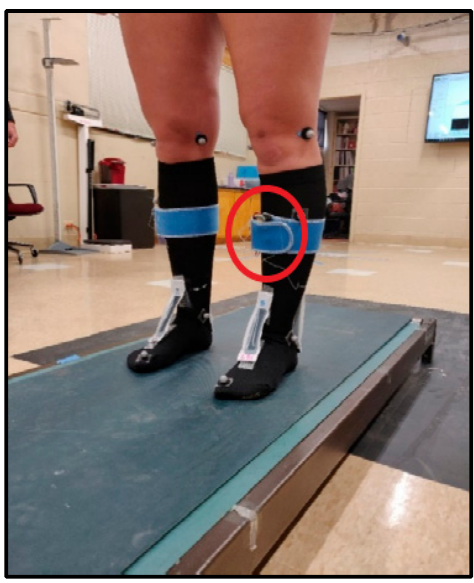
Figure 9. A sock prototype was used for the slip and trip experiment. SRS module location in the red circle.